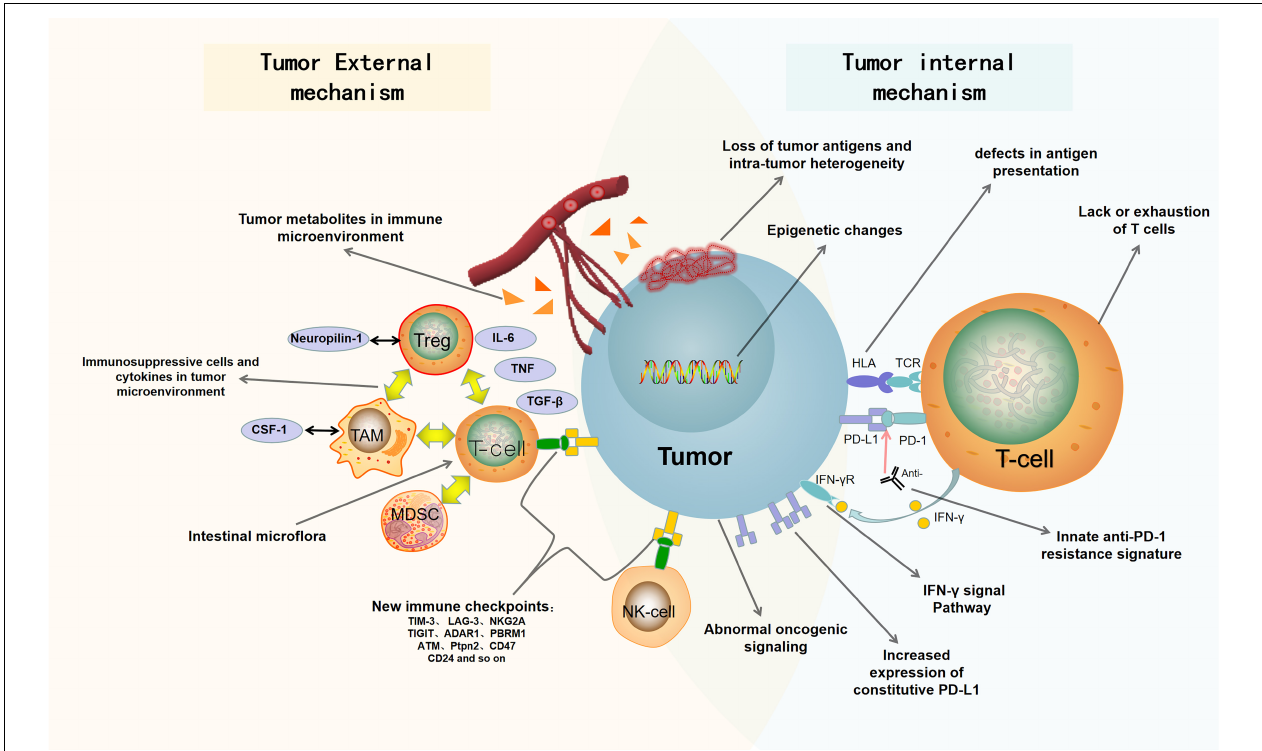
FIGURE 1 | Summary of drug resistance in tumor immunotherapy.The mechanisms of drug resistance and immune escape in tumor immunotherapy include tumor cell-internal and -external factors. The internal factors include loss of tumor antigens and intratumor heterogeneity, defects in antigen presentation, abnormal oncogenic signaling and IFN- γ signal pathway, innate anti-PD-1 resistance signature, increased expression of constitutive PD-L1, epigenetic changes, and lack or exhaustion of T cells. The external factors include immunosuppressive cells and cytokines in tumor microenvironment, tumor metabolites in immune microenvironment, new immune checkpoints, and intestinal microflora. PD-1, programmed death 1; PD-L1, programmed death ligand 1; Anti, Anti-PD1/anti-PDL1; HLA, human leukocyte antigen; TCR, T-cell receptor; IFN- γ , interferon- γ ; IFN- γ R, Interferon- γ receptor; Treg, regulatory T cell; Neuropilin-1, neurociliary protein 1; TAM, tumor associated macrophage; CSF-1, macrophage colony stimulating factor; MDSC, myelogenous suppressor cell; IL-6, interleukin-6; TGF- β , transforming growth factor- β ; TNF, tumor necrosis